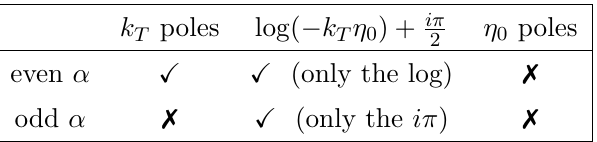
Table 1. In this table we indicate which parts of the trimmed wavefunction, arising from contact diagrams, can contribute to cosmological correlators and which cannot. Here α is the number of spatial derivatives contracted with polarizations tensors, as defined in (2.24), and these results apply for three spatial dimensions, d = 3